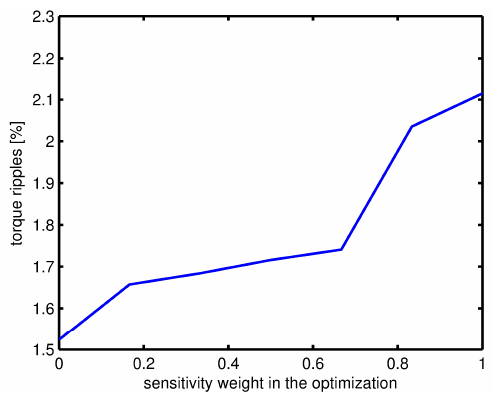
Figure 12. Torque ripples versus weight γ s .